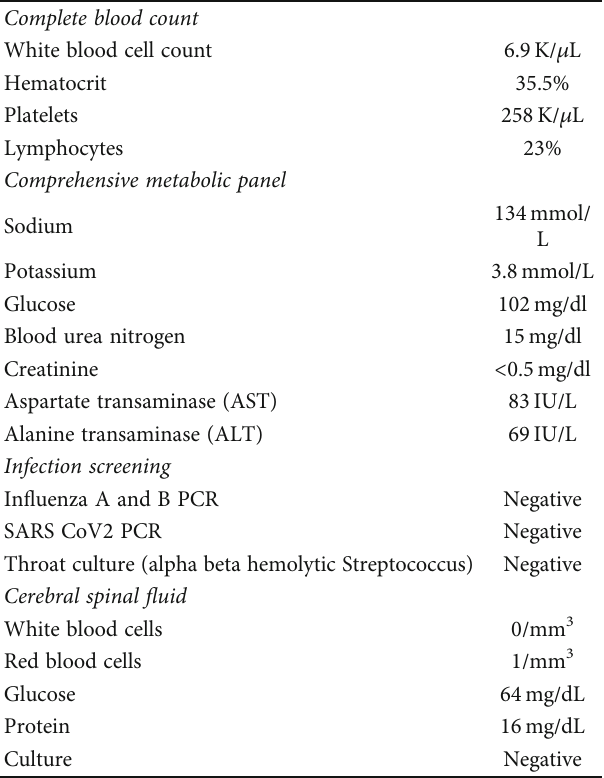
Figure 1: Cornell Assessment of Pediatric Delirium (CAPD). Table 1: Laboratory test